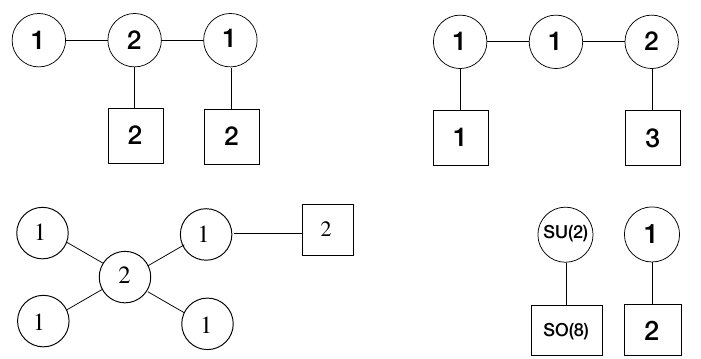
Figure 3 . Mirror dual framed linear quivers (top row) and the new mirror pair after applying gauging